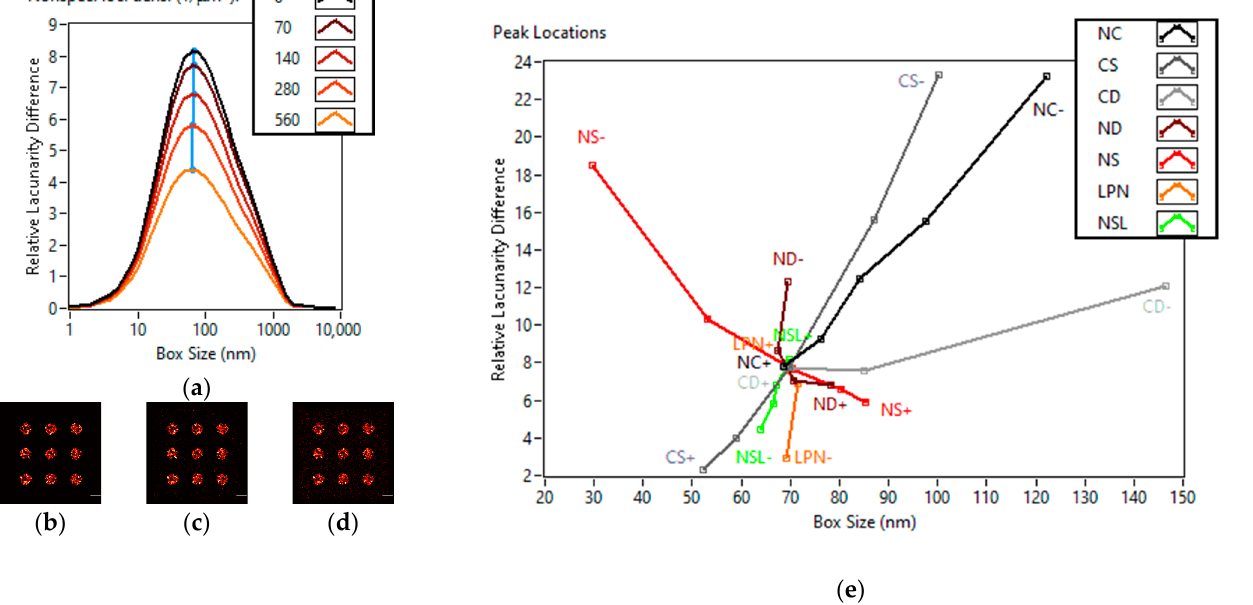
Figure 4. Effects of changing nonspecific localization densities on lacunarity and summary of the simulation results. Lacunarity difference curves of TestSTORM generated datasets of different nonspecific localization densities ( a ). Three super-resolution images of the simulated data with nonspecific localization densities of 0/µm 3 ( b ), 140/µm 3 ( c ) and 560/µm 3 ( d ) are also shown. Scale bars are 1µm. The peak positions for each simulation in order ( e ). Number of clusters (NC), cluster size (CS), cluster distance (CD), nanofocus density (ND), nanofocus size (NS), localizations per nanofocus (LPN) and nonspecific localization density (NSL).